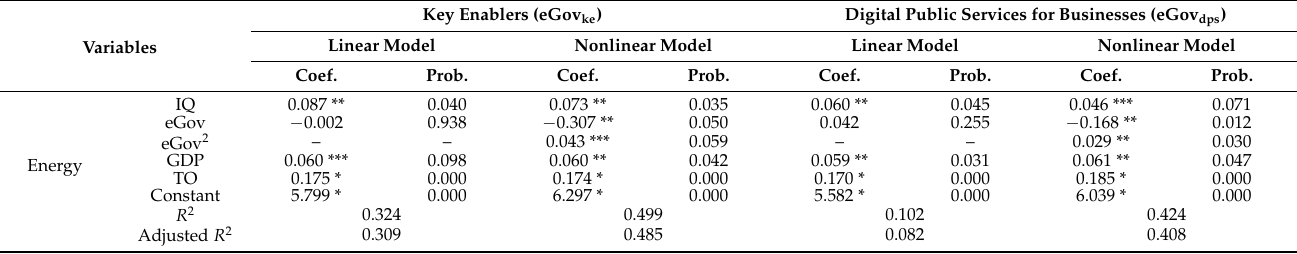
Table 7. The findings of the long-run relationship between the analyzed variables: CCR.